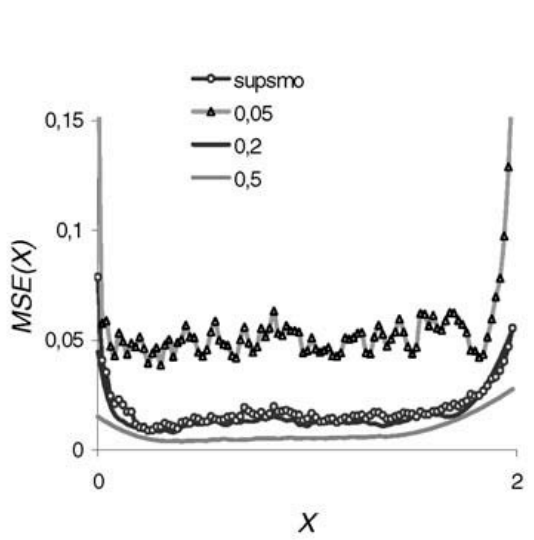
Figura 3 – Modello I: varianza degli stimatori.